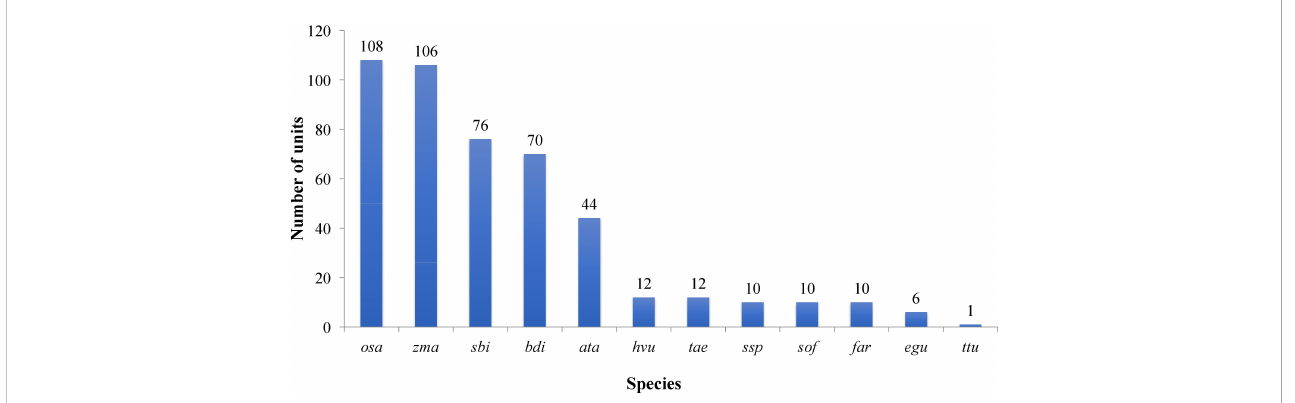
FIGURE 4 Plot showing the conservation pro fi le of identi fi ed miRNAs. Ata- Aegilops tauschii , bdi- Brachypodium distachyon , egu- Elaeis guineensis , far- Fragaria ananassa , Hvu- Hordeum vulgare , osa- Oryza sativa , sbi- Sorghum bicolor , sof- Saccharum of fi cinarum , Tae- Triticum aestivum - ssp- Saccharum sp , zma- Zea mays , ttu- Triticum turgidum .